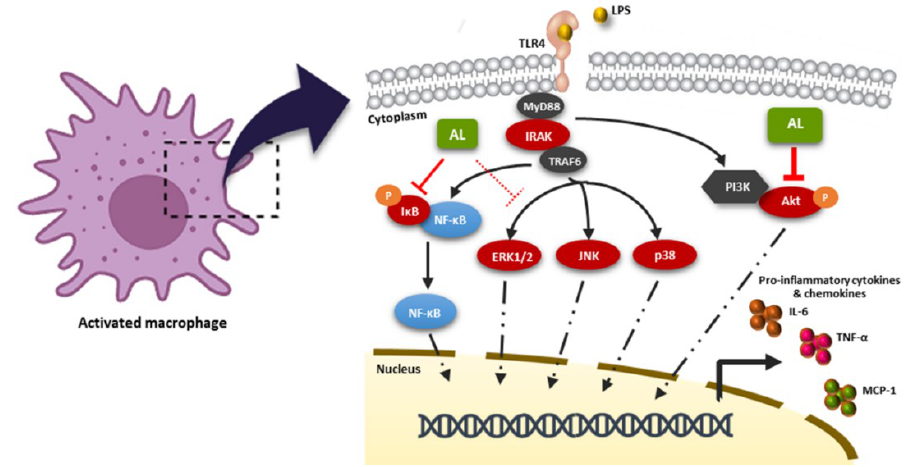
Figure 10. Schematic picture proposing that the AL extract regulates the LPS-stimulated inflammatory response. AL extract drastically inhibits the activation of the Akt and NF-κB signal transduction pathways, while moderately suppressing the MAPK signaling, resulting in the downregulation of inflammatory cytokine and chemokine production in response to LPS